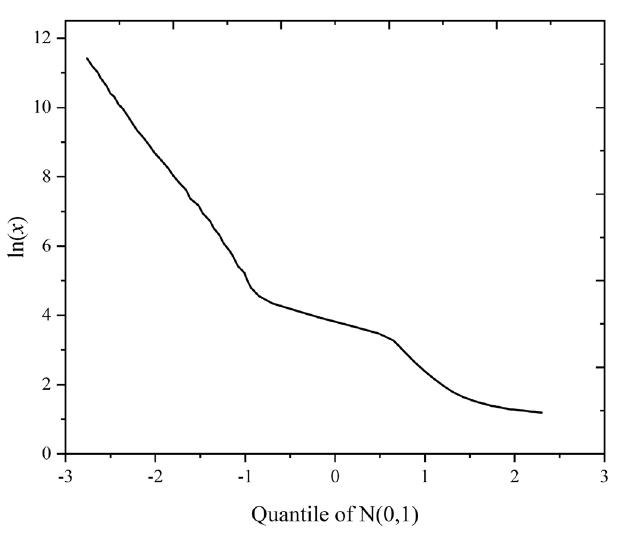
Figure 7. Plot of ln x versus the quartiles of N(0,1) obtained based on the data in Fig.